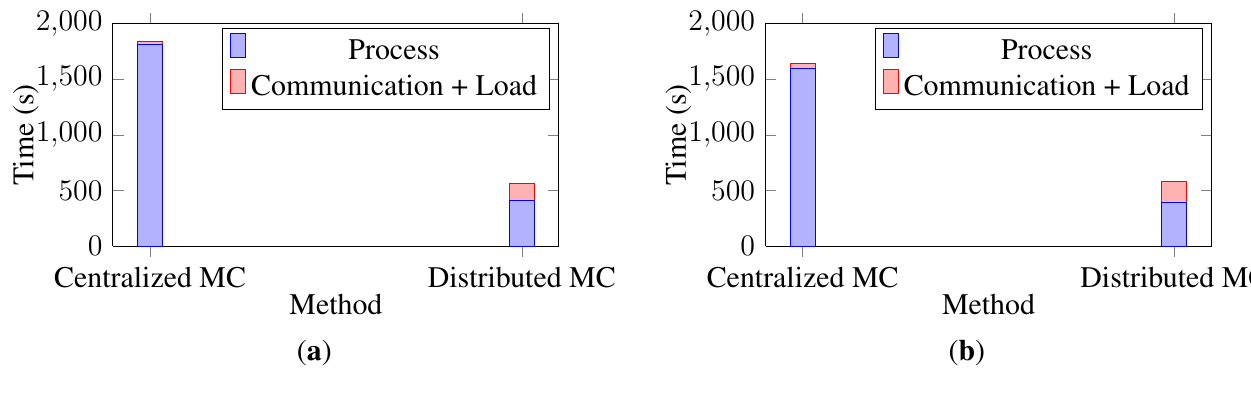
Figure 13. Execution times for the distributed and centralized matrix completion on human